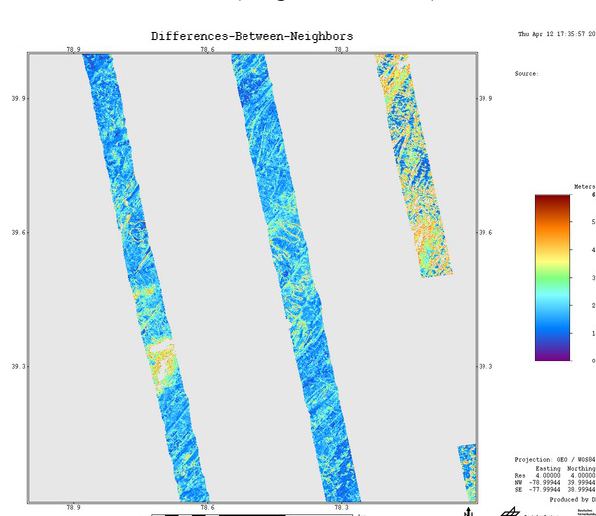
Figure 9: Difference between TanDEM-X and SRTM-C, tile N39W79, range of values [-20; 20]